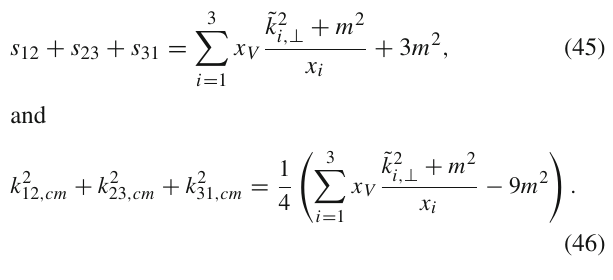
Fig. 10 Three valence quarks coupled in pairwise HO interaction